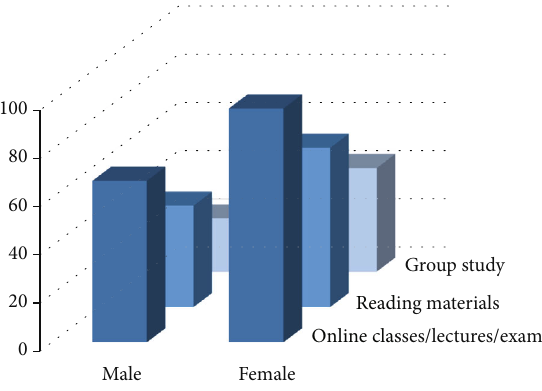
Figure 5: Educational